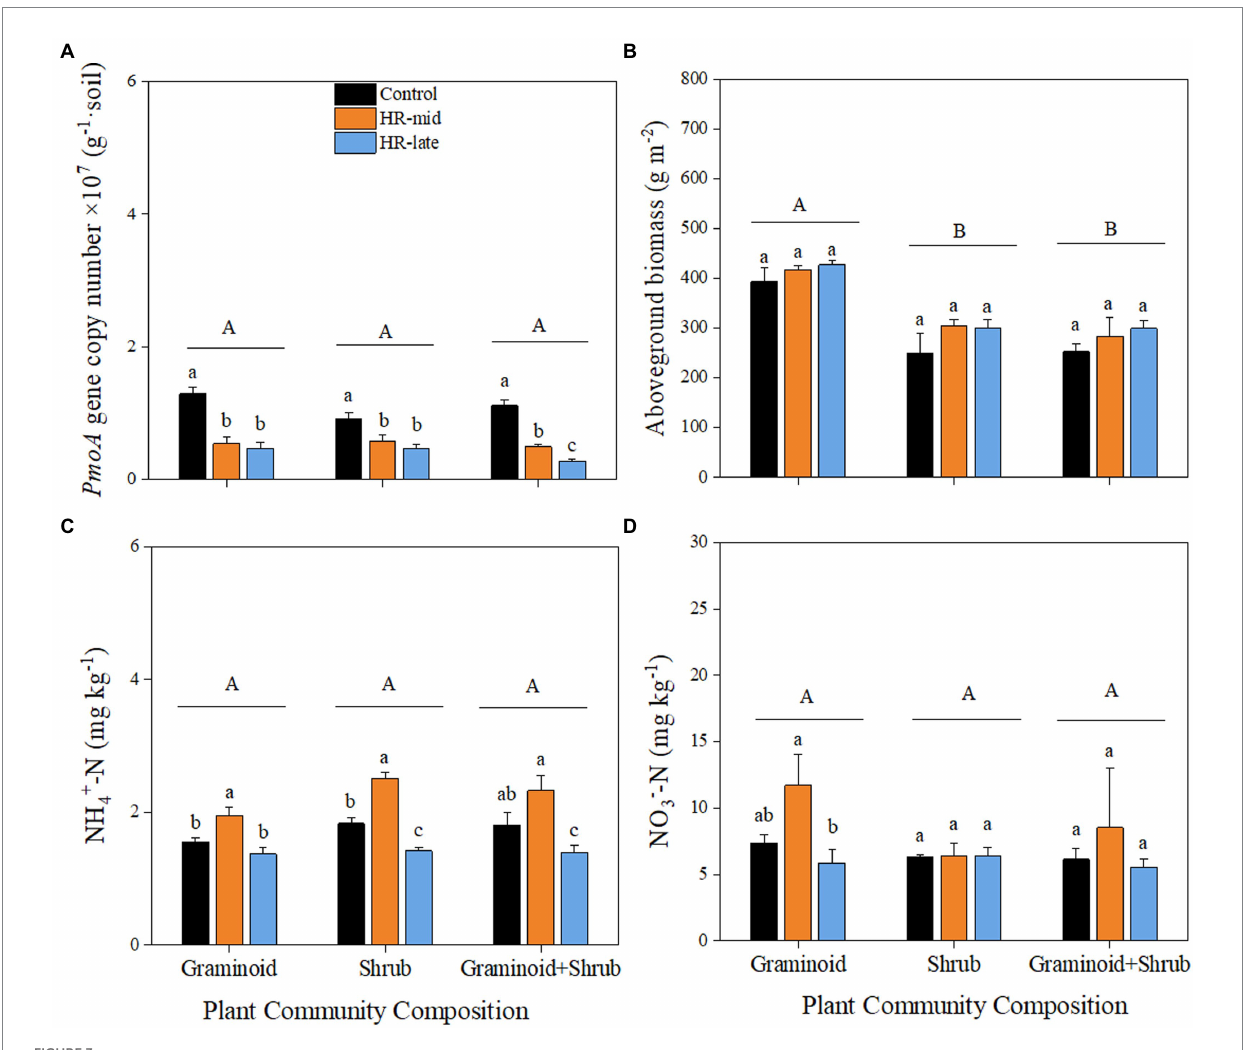
FIGURE 3 Responses of pmoA abundance (A) , above-ground biomass (AGB) (B) , NH 4+ -N (C) and NO 3 − -N (D) to heavy rainfall treatments in three plant communities. Different letters above bars indicate significant difference among treatments at p ≤